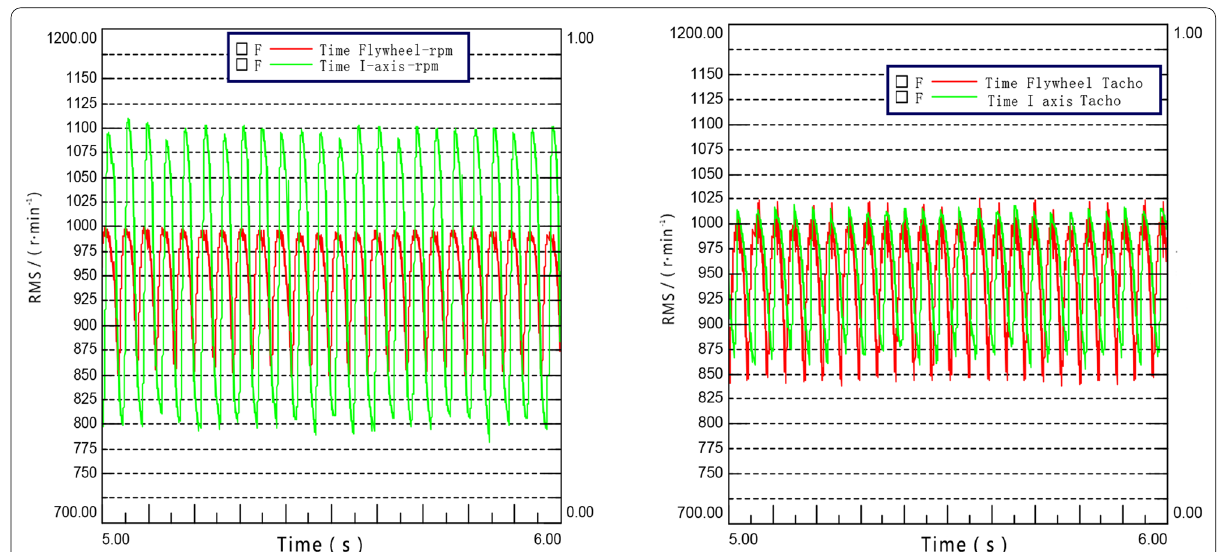
Figure 13 Flywheel and first shaft speed fluctuations under idle condition (left: traditional clutch; right: wide-angle, large-hysteresis, multistage damping clutch)